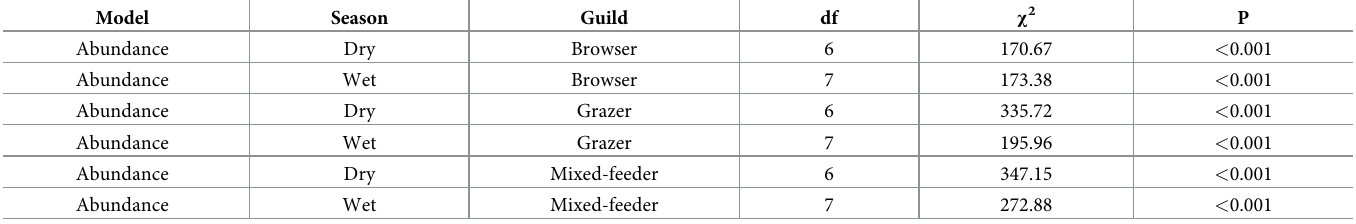
Table 3. Generalized linear model outputs showing that configurations have significantly different herbivore species abundance for each feeding guild (i.e., browser, grazer, and mixed-feeder) in both the wet and dry seasons,